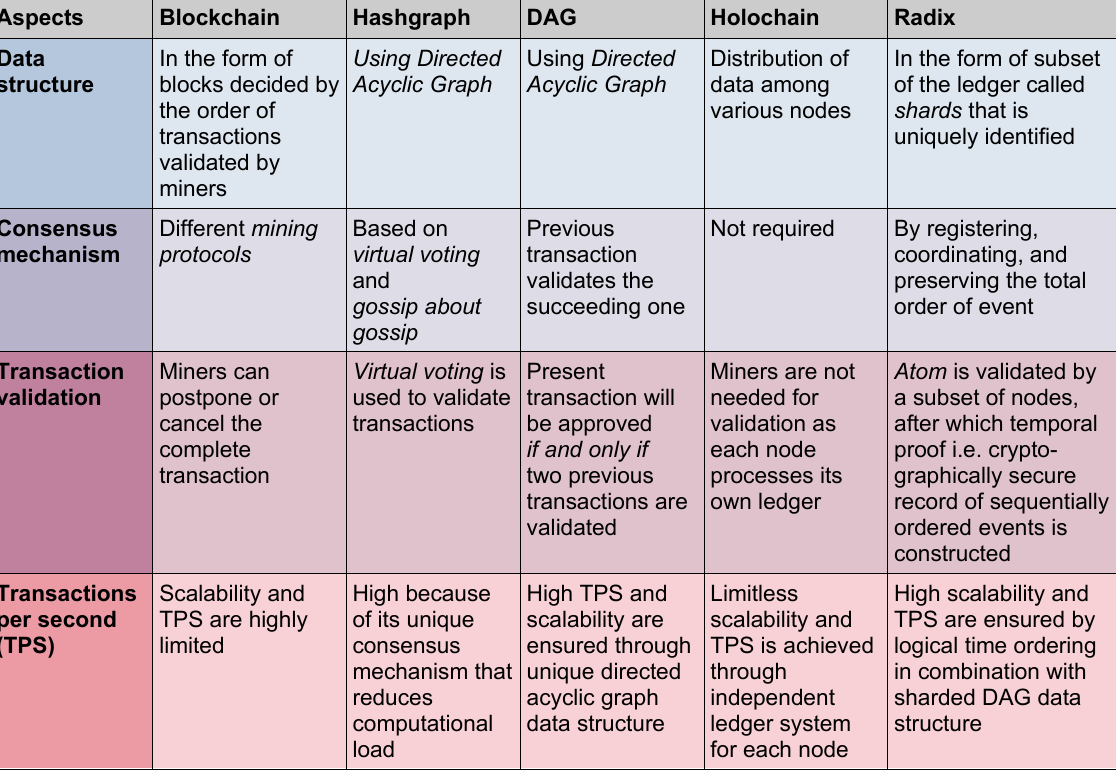
Fig. 1. Comparison of 5 major DLT